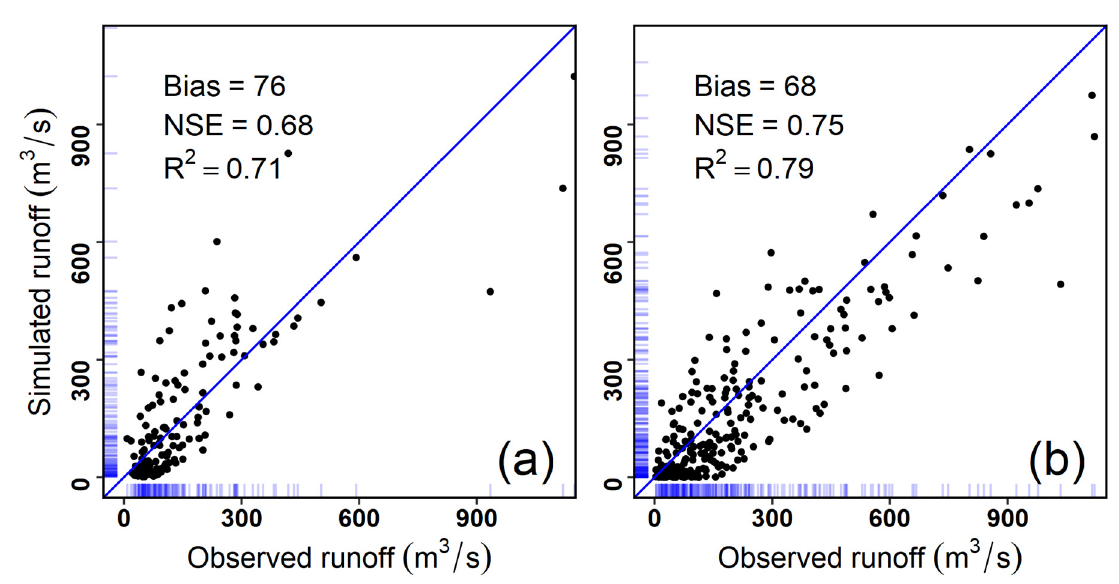
Figure 3. The streamflow simulation using SWAT model in calibration ( a ) and validation ( b ). The blue line is the 1:1 line. The rug represents the data distribution density.